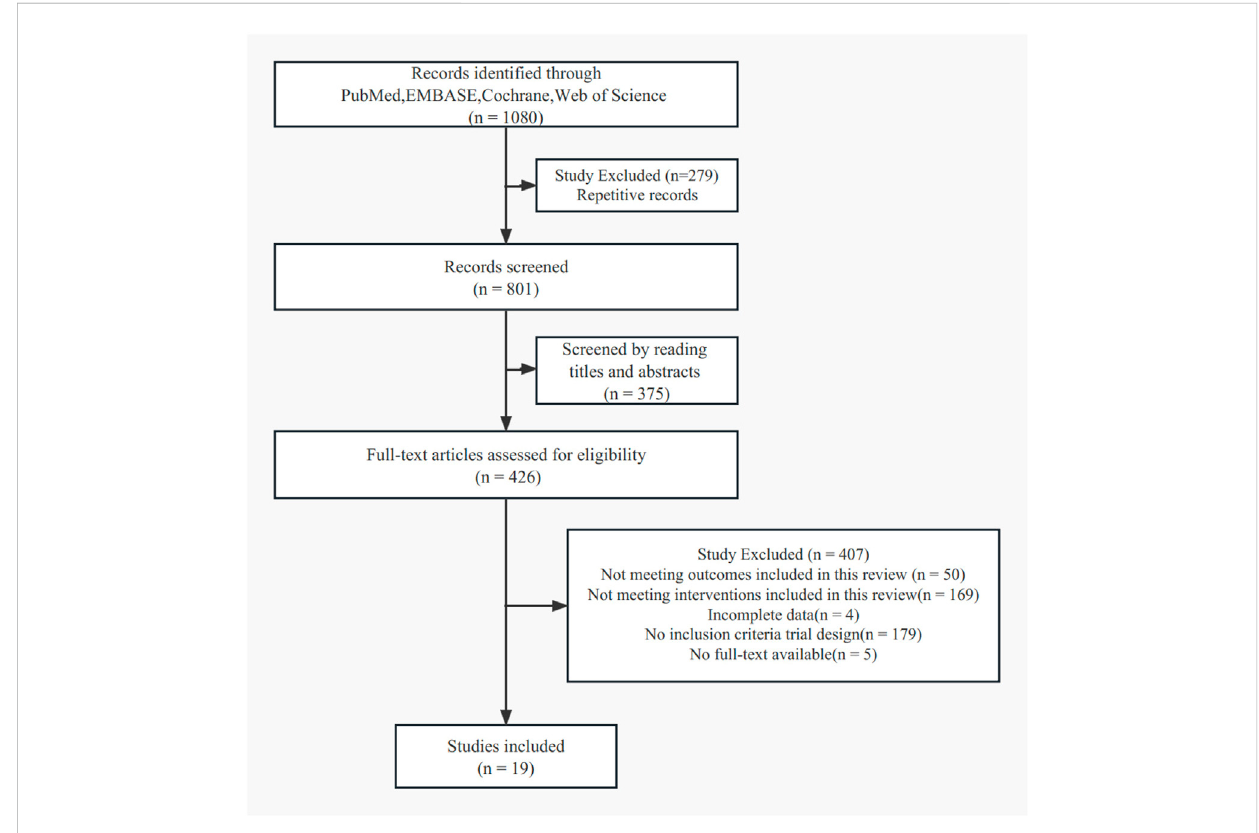
FIGURE 1 Flow diagram of the selection